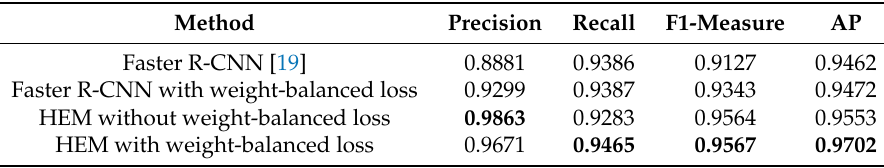
Table 3. Comparison of HEM and new loss